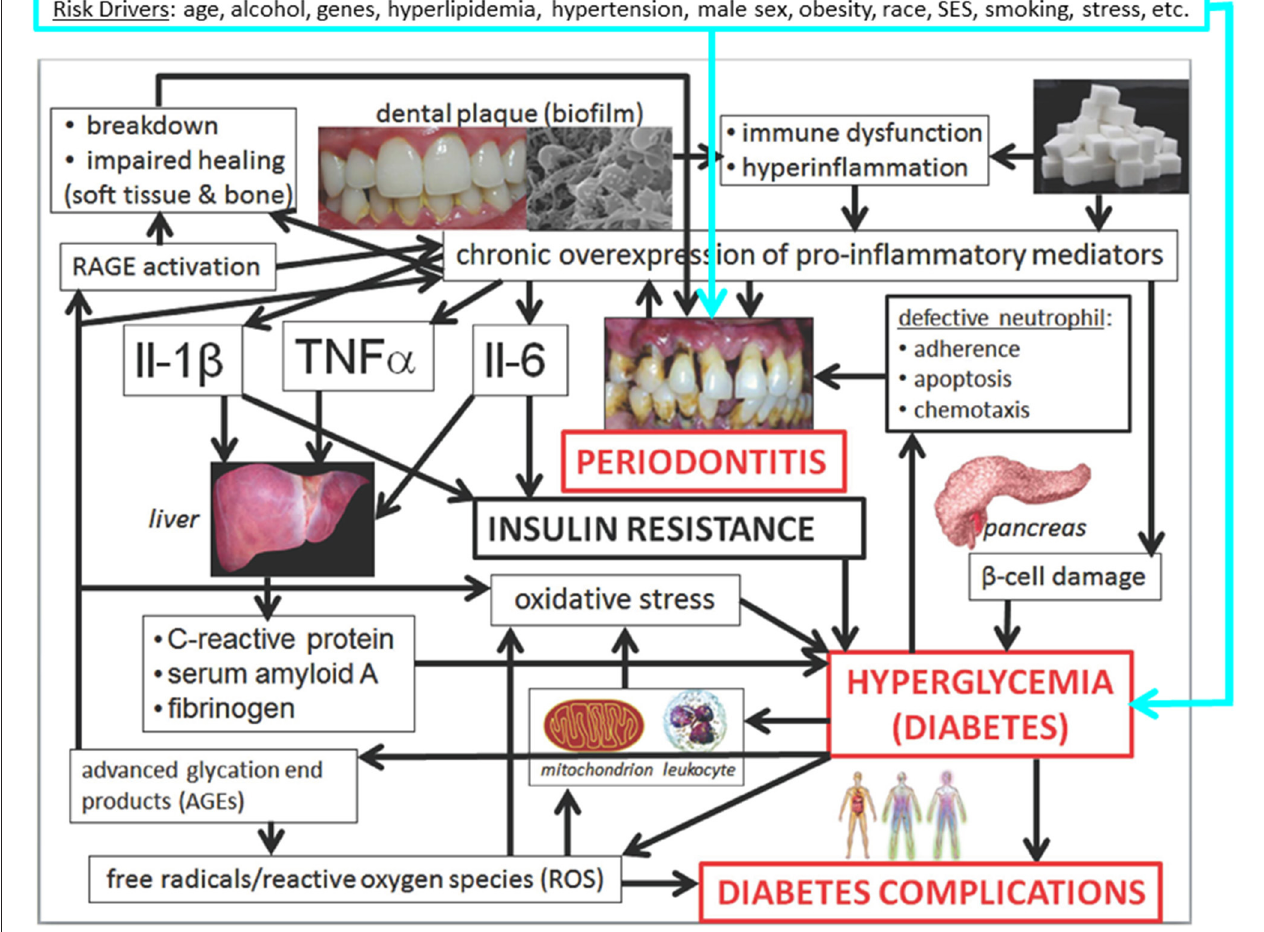
FIGURE 1 | Mechanisms underlying the associations between periodontitis and hyperglycemia/diabetes and its complications: conceptual model (14). Slightly modified Figure 31.10 in Borgnakke et al. ( 14). Please see the full description and accreditations at